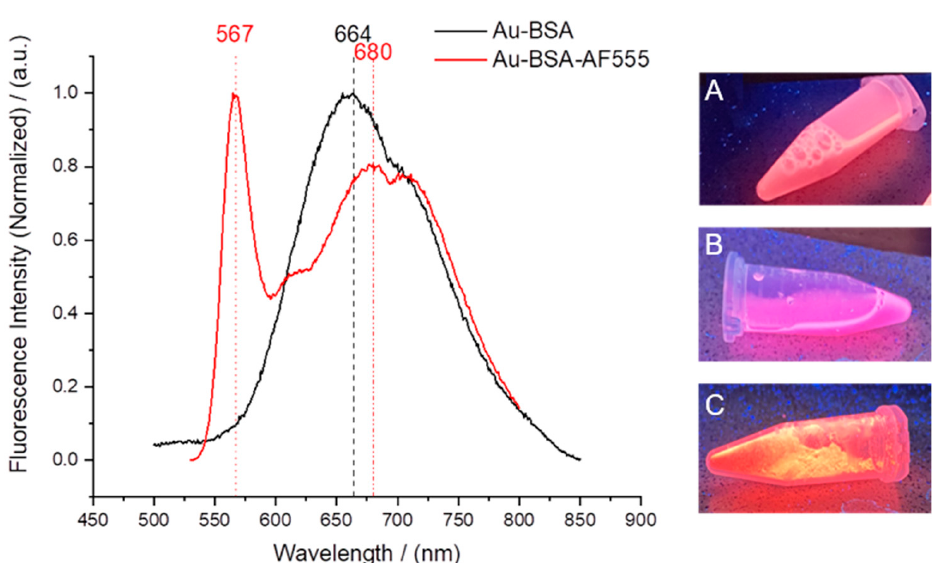
Figure 5. ( Left ): Fluorescence spectra of Au-BSA and Au-BSA-AF555 nanoclusters. ( Right ) Images of fluorescing nanoclusters under UV irradiation: Au-BSA dispersion ( A ), Au-BSA-AF555 dispersion ( B ), and solid Au-BSA-AF555 freeze-dried with trehalose ( C ). Table 2. Characterization of hard-fat suppositories, loaded with either Au-GSH nanoparticles or Au- BSA nanoclusters. Given are weight percentages with respect to the total weight of the suppository ( ± indicates the standard